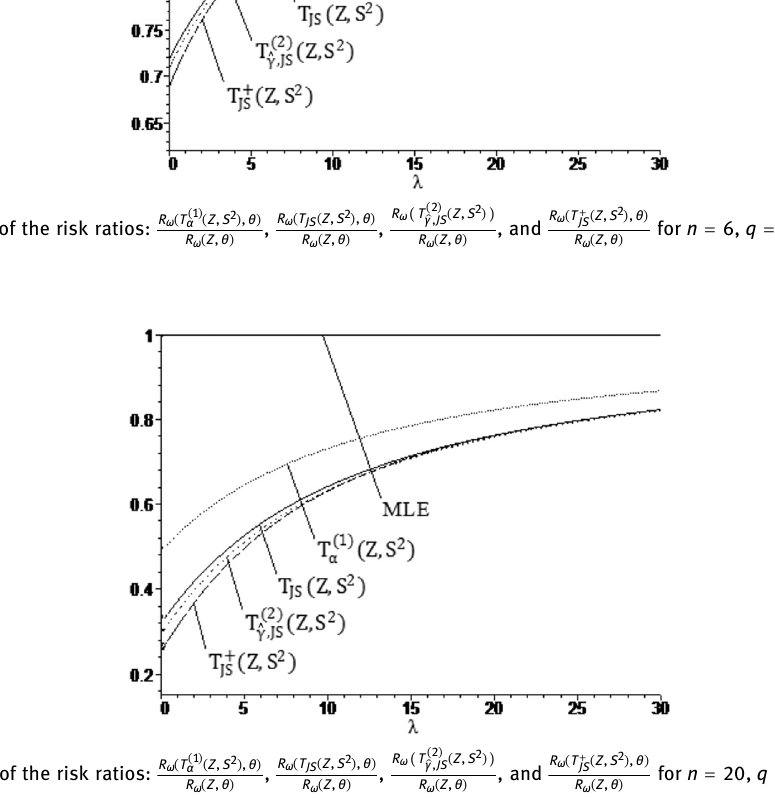
Figure 4: Curves of the risk ratios: R T Z S θ